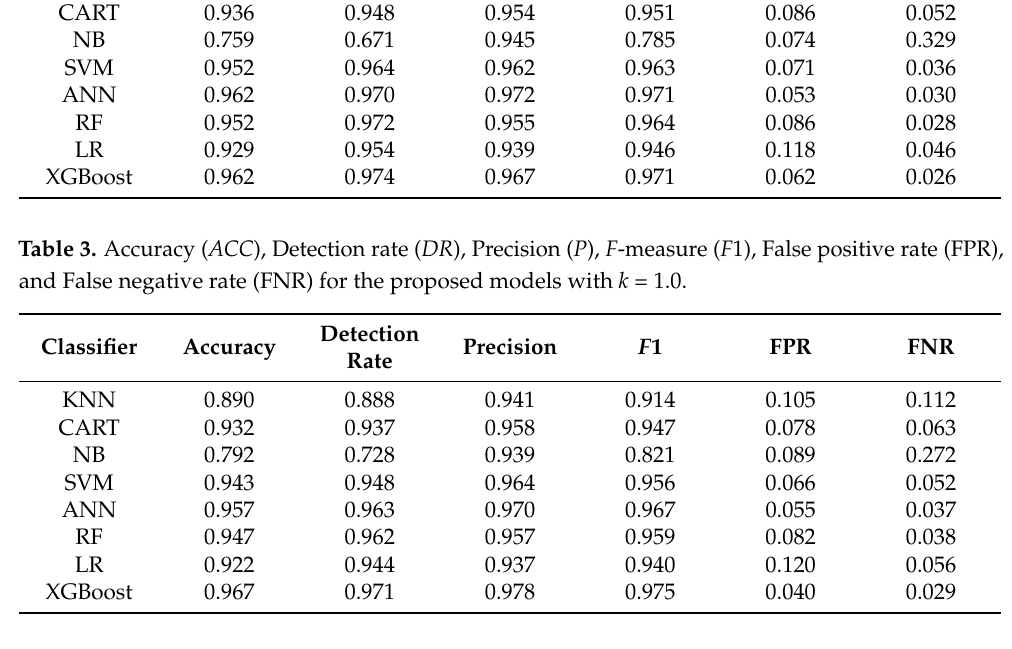
Table 4. Accuracy ( ACC ), Detection Rate ( DR ), Precision ( P ), F -measure ( F 1), False positive rate (FPR), and False negative rate (FNR) for the proposed models with k = 1.5.